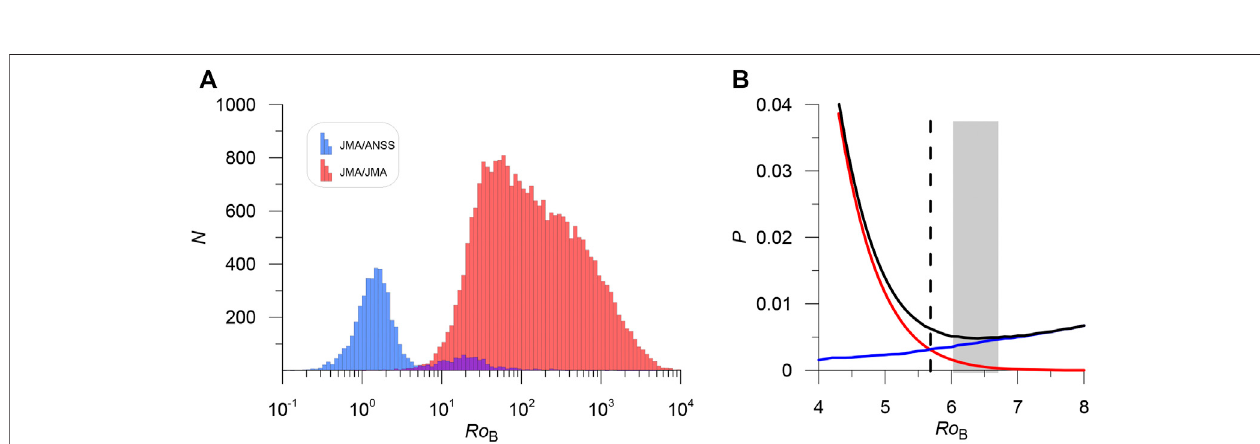
FIGURE5|(A) Comparison ofthedistribution ofthebasemetric Ro B (Eq.4) forANSS/JMApairs (bluehistogram) andthesame metricforJMA/JMAearthquakes (redhistogram). (B) Thresholdoptimization:theredlineshowstheprobabilityofmissingaduplicate,thebluelineistheprobabilityofafalseduplicate(seetext),theblack line is the total probability of errors of the fi rst and second kind, the dashed line Ro B (cid:2) 5 . 7 corresponds to an equal number of errors of the fi rst and second kind (the number of false duplicates is equal to the number of missed duplicates), the estimate of the total number of errors is approximately .6%, the gray bar shows the range of values of the metric Ro B (cid:2) 6 ÷ 6 . 7, minimizing the total number of errors, approximately .5%.